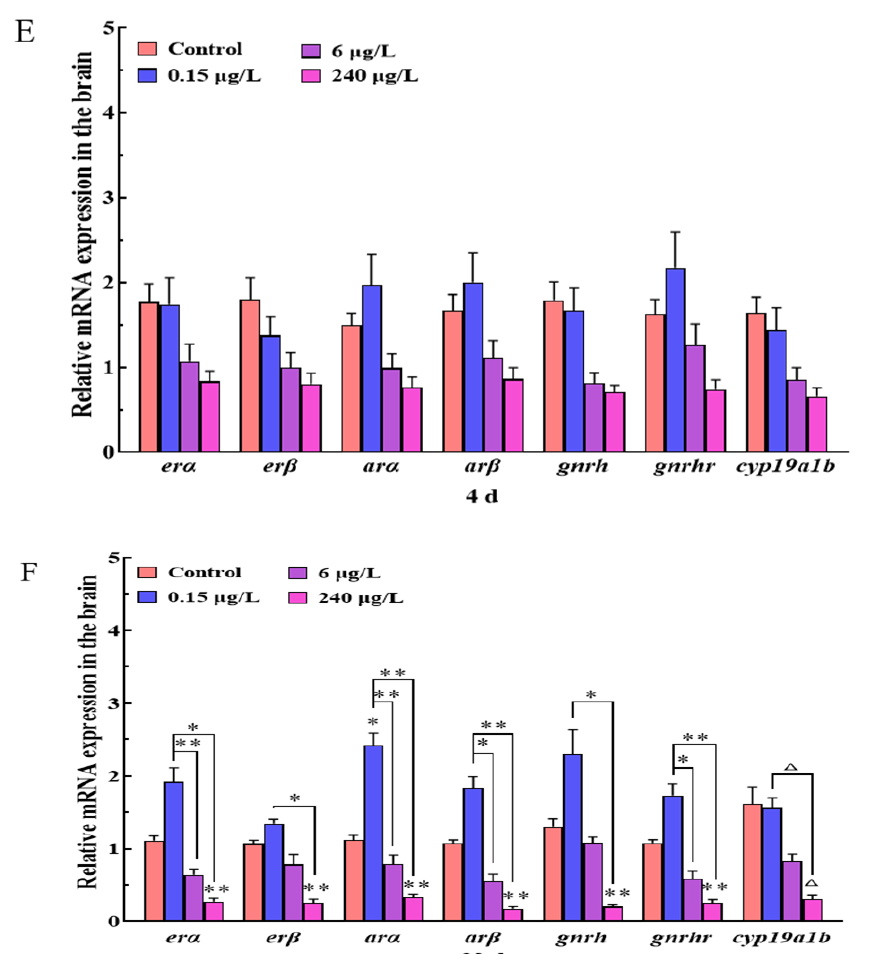
Figure 1. ( A – D ): The brain histopathology of male mosquitofish from the control (( A ): 4d and ( C ): 32d) and PrP-severely affected group (240 μg/L PrP) (( B ): 4d and ( D ): 32d). Bars = 100 μm, n = 20. Black arrows: blurred cell boundaries; Red arrows: cell vacuolation; Green arrows: cytomorphosis. SM: stratum marginale, SC: stratum centrale, PGZ: stratum periventriculare tecti optici, TSvl: Nucleus ventrolateralis tori semicircularis (ventrolateral nucleus of semicircular torus). ( E ) and ( F ): Transcriptional levels of HPGL axis related genes in the brain of male mosquitofish suffered from 0, 0.15, 6 and 240 μg/L PrP treatment for 4d ( E ) and 32d ( F ), respectively. Data were analyzed by t -test and Tukey’s multiple comparisons. Asterisks (*) above the bars indicate statistical significance (* p < 0.05, ** p <0.01, △ p < 0.08). er α , estrogen receptor alpha; er β , estrogen receptor beta; ar α , androgen receptor alpha; arβ , androgen receptor beta; gnrh , gonadotropin releasing hormone; gnrhr , gonadotropin releasing hormone receptor; cyp19a1b , cytochrome P450, family 19, subfamily A, polypeptide 1b.